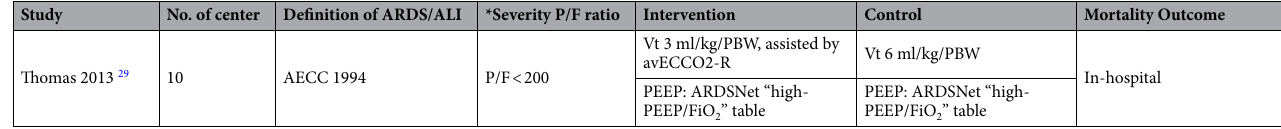
Table 1. Characteristics of the included trials. ARDS Acute Respiratory Distress Syndrome, ALI Acute Lung Injury, P/F PaO